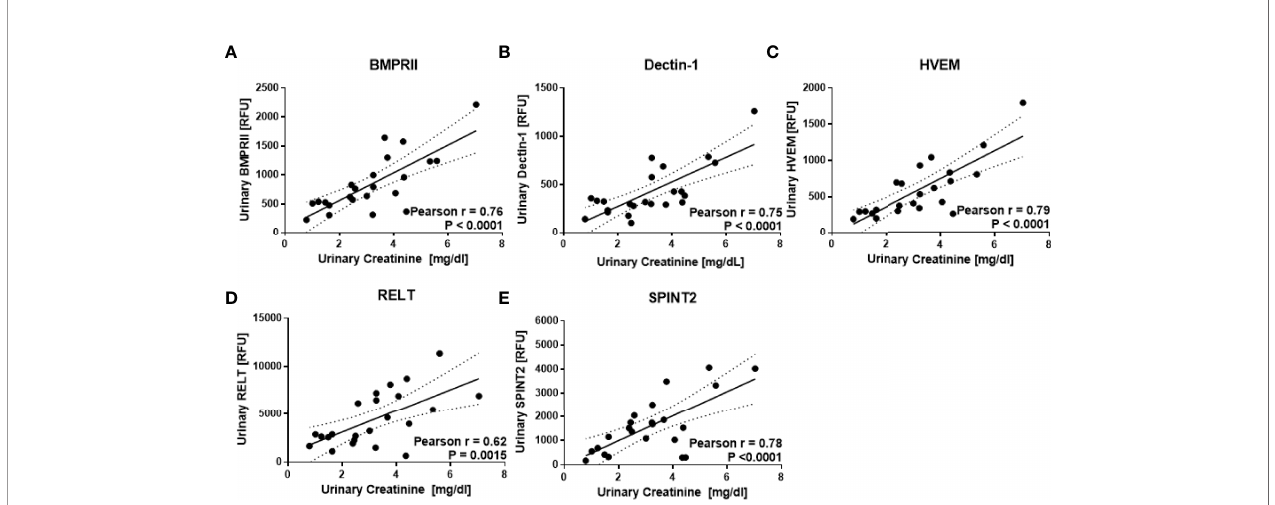
FIGURE 3 | Urine proteins that correlate best with urine creatinine. The aptamer-based screen identi fi ed fi ve urine proteins that correlated best with urine creatinine but not differ between subject groups. As described in Figure 1 , the levels of 1129 urine proteins were assayed in 7 active LN, 8 inactive LN, 8 healthy controls using an aptamer-based proteomic screen. Of these, urine BMPRII, Dectin-1, HVEM, RELT, and SPINT2 (A – E) exhibited the highest Pearson R correlation with creatinine but did not differ signi fi cantly between the subject